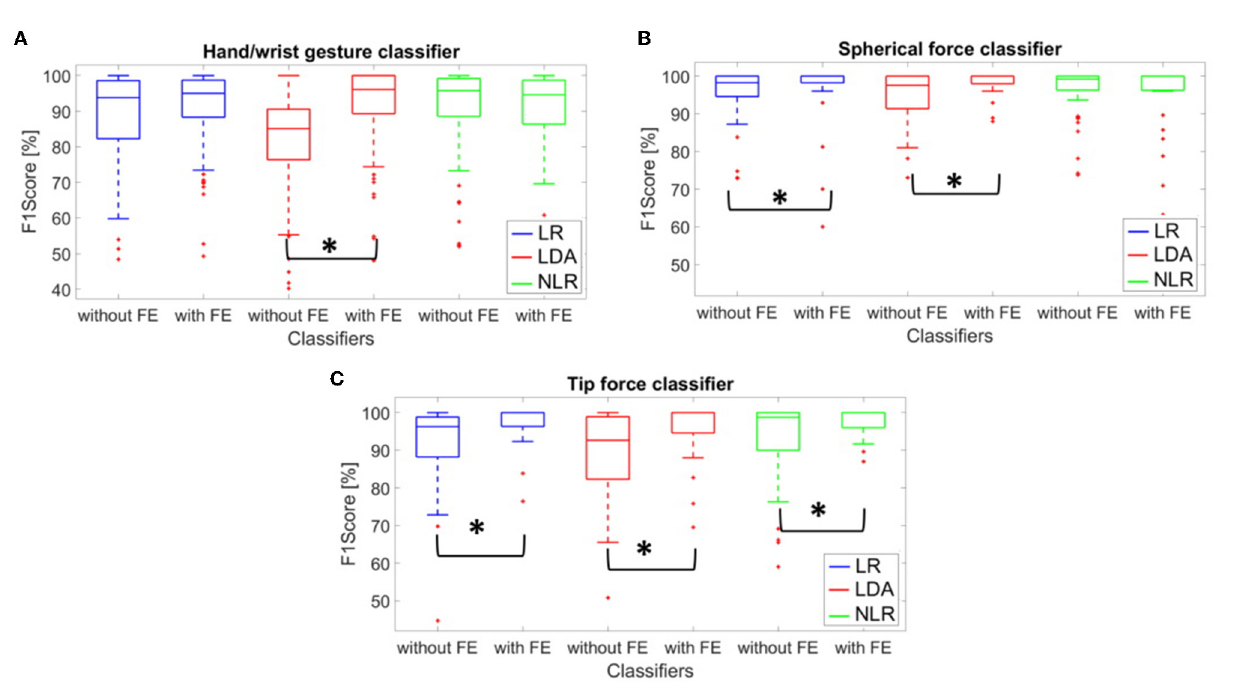
FIGURE3 (A–C) F1 score mean values calculated for 15 transradial amputees using the LR (in blue), LDA (in red), and NLR (in green) algorithms for the “hand/wrist gestures classifier” (A) , the “spherical force classifier” (B) , and (C) the “tip force classifier” algorithm (C) , tested on the “test set” with and without the five time-domain FE. Statistical significance is indicated by